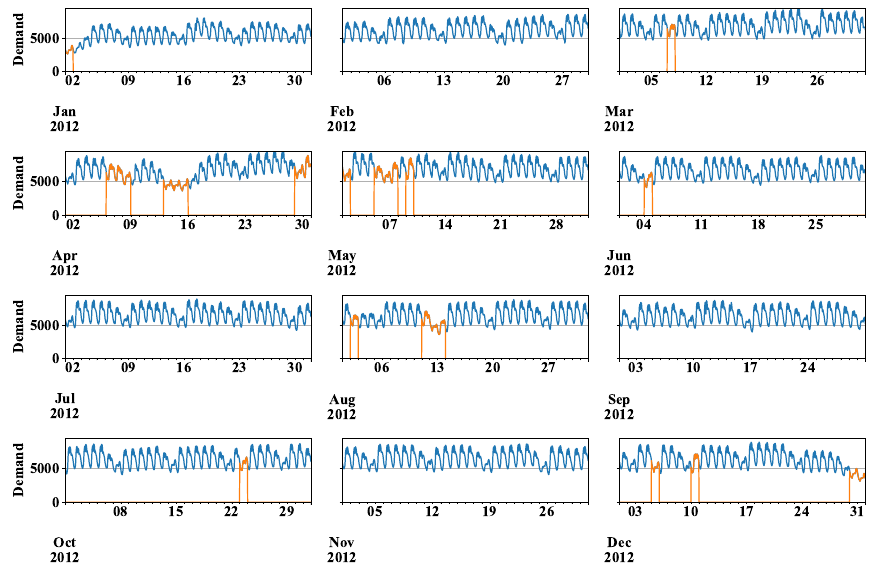
Figure A1. Complete demand profile for a year: